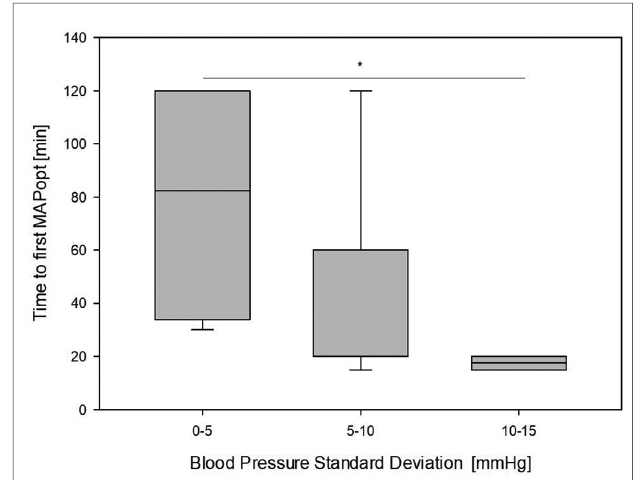
FIGURE 2 Time required to initially identify the optimal mean arterial blood pressure (MAPopt) on the y -axis. On the x -axis, the patients are grouped according to their extent of spontaneous blood pressure fl uctuations depicted as blood pressure standard deviation. In patients with higher fl uctuations the initial value could be identi fi ed quicker. According to the Shapiro – Wilk test, the data are normally distributed. The analysis of variance indicates statistical signi fi cance ( p =0.014). The bar with * indicates signi fi cant results in the subgroup analysis.